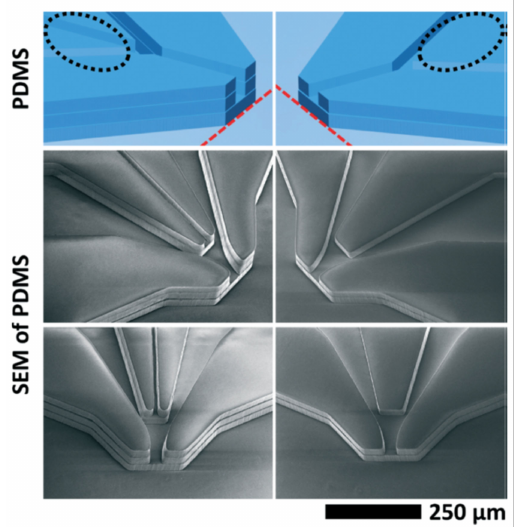
Figure 3. Illustration of the multilayer 3D PDMS microfluidic GDVN devices (reproduced with permission from Reference